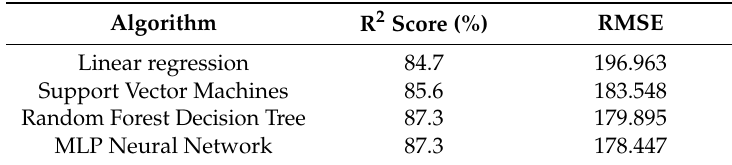
Table 3. Accuracy comparison of hour-ahead predictions conducted by various